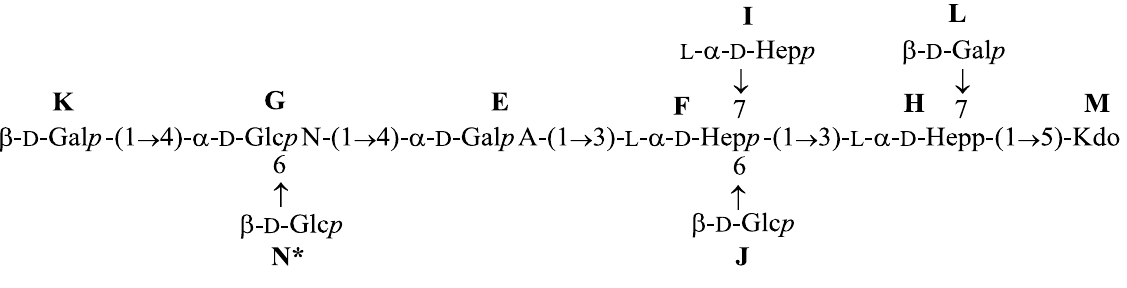
Figure 6. Structure of the core oligosaccharide from P. shigelloides O24 (strain CNCTC